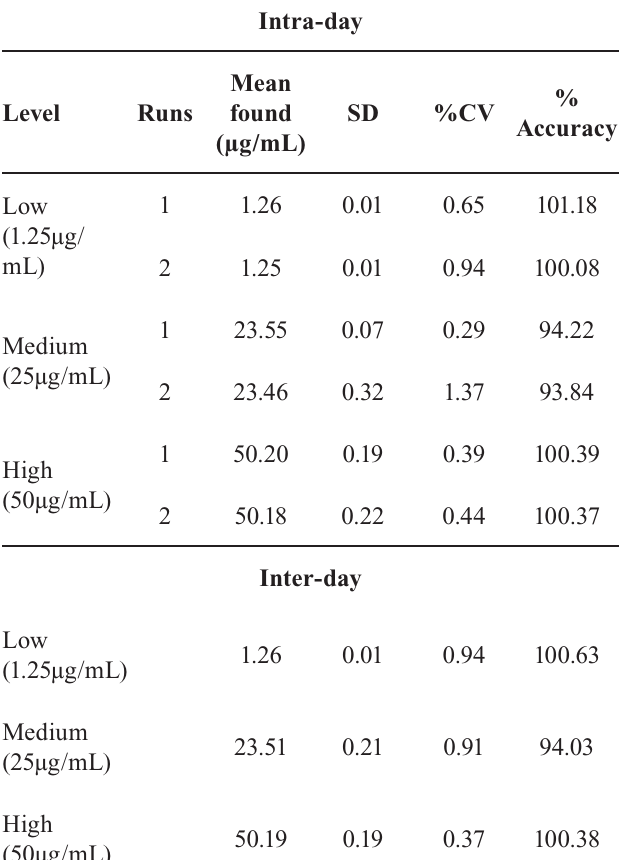
TABLE III - Intraday and interday accuracy and precision data of the